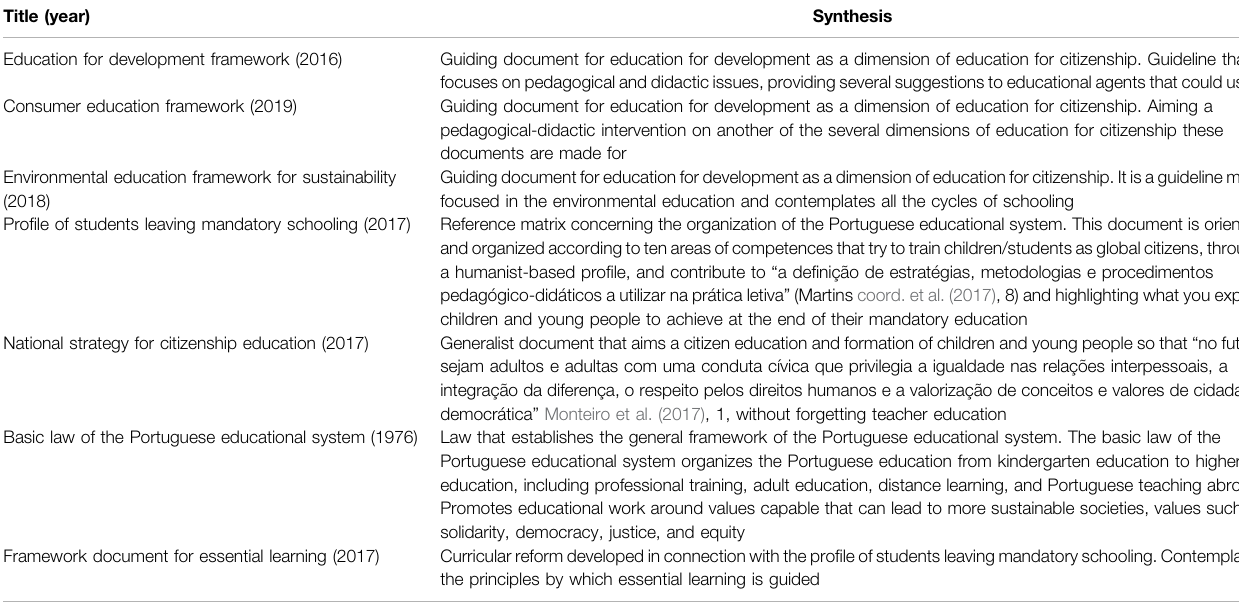
TABLE 2 | The seven documents of the Portuguese educational system under